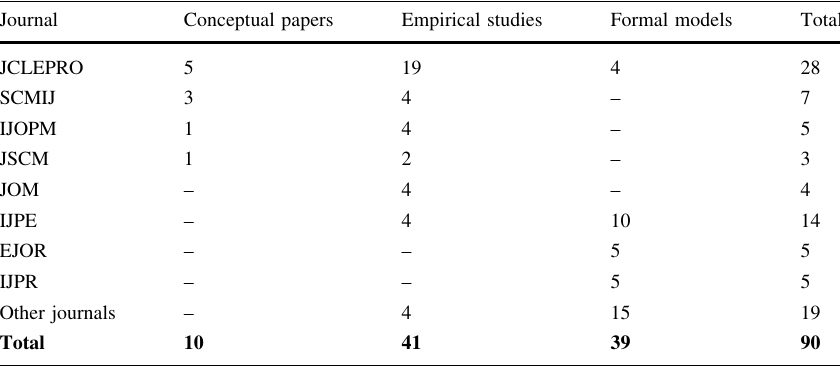
Table 5 Distribution of sample papers over scientific